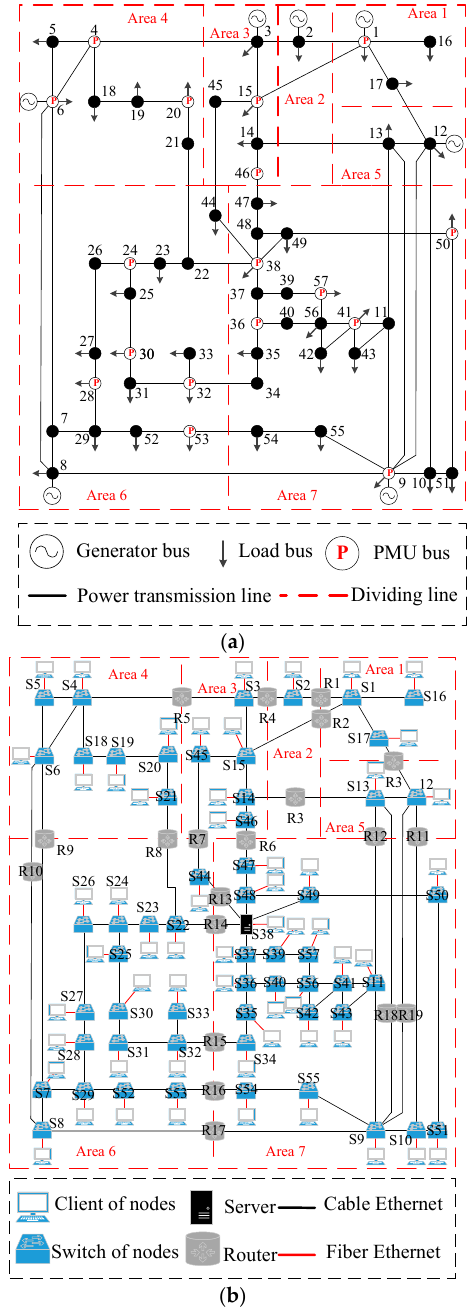
Figure 16. Topology of the IEEE 57-bus system. ( a ) Topology of the power system; ( b ) topology of the communication system.